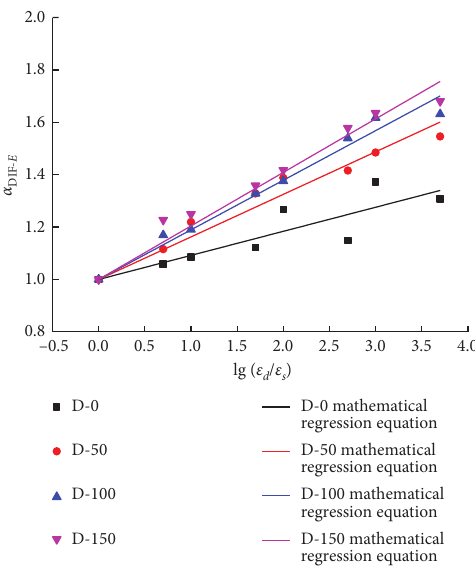
Figure 11: The effect of strain rate on the elastic modulus dynamic increase